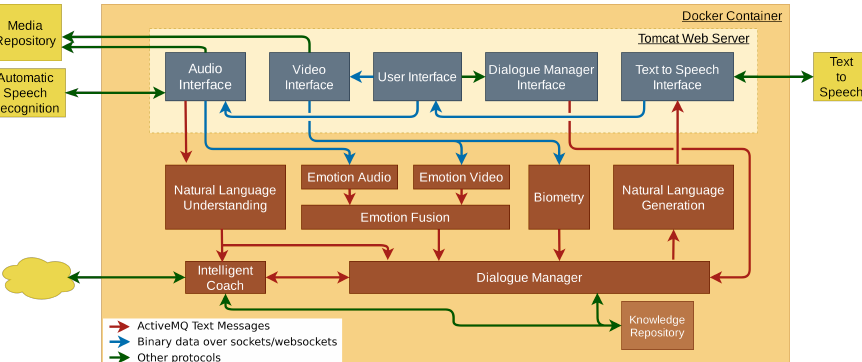
Figure 9. EMPATHIC system architecture. Orange is the Docker container. Brown components are running directly on the Docker container as well as the light yellow Tomcat Web server. Then, dark blue components are running as web services within the Tomcat Server. Yellow components are exter- nal services. Arrow colours indicate the communication protocol between the involved